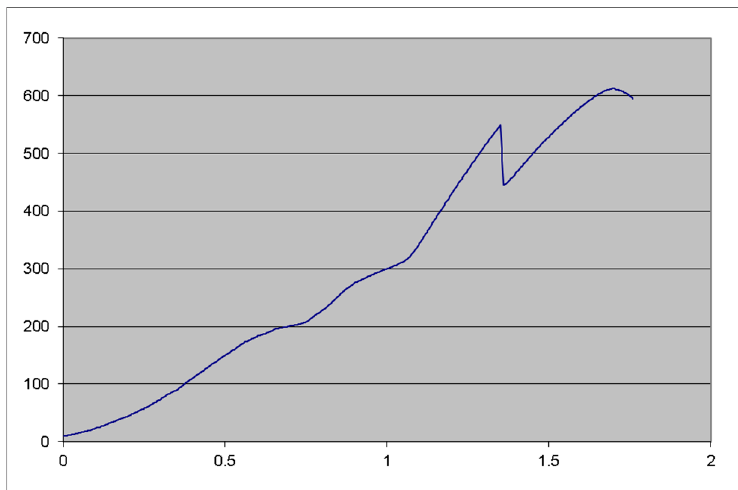
Figure 12. Statical testing of P1 implant. There is almost a linear relation between the force applied and